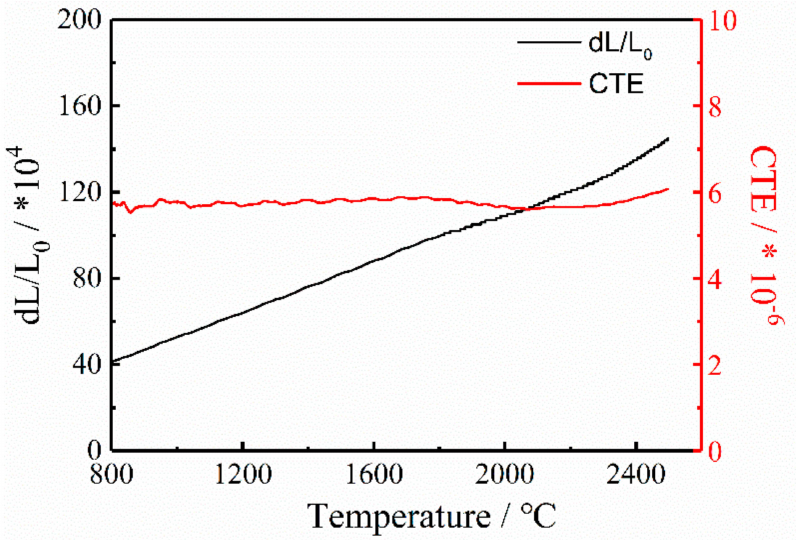
Figure 7. CTE of the CNTs reinforced pyrocarbon matrix of CC/C